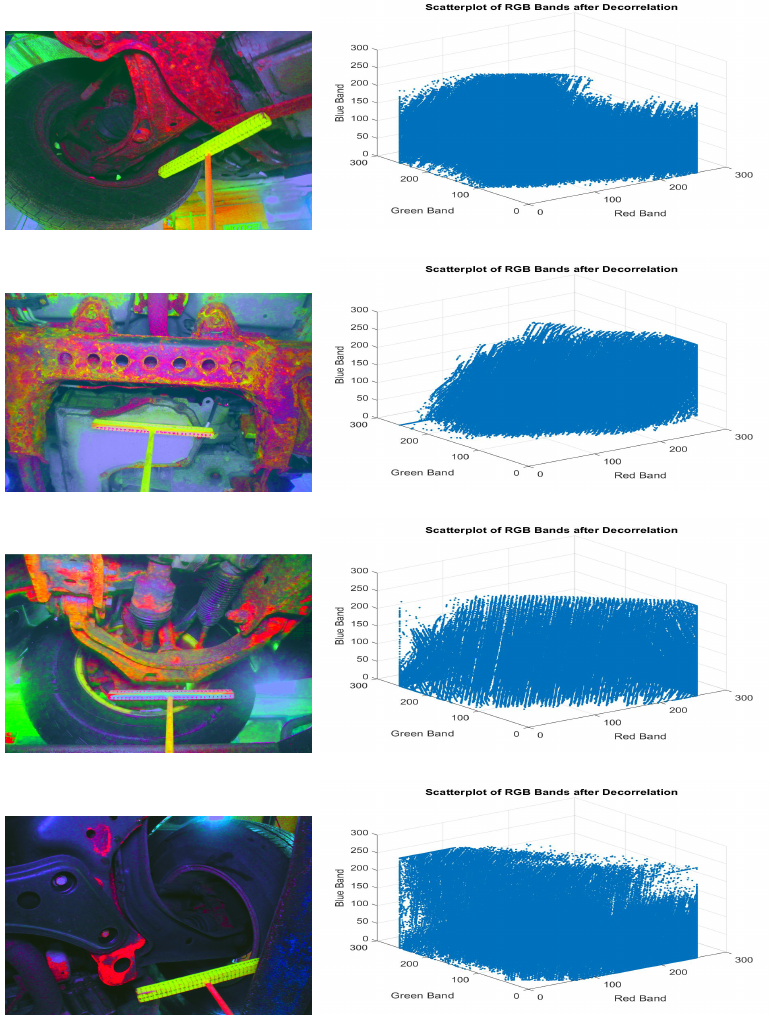
Figure 3. Illustration of Rust Pixel Detection in the de-correlated bands of the original images ( left ) and respective visualization of de-correlated RGB bands ( right